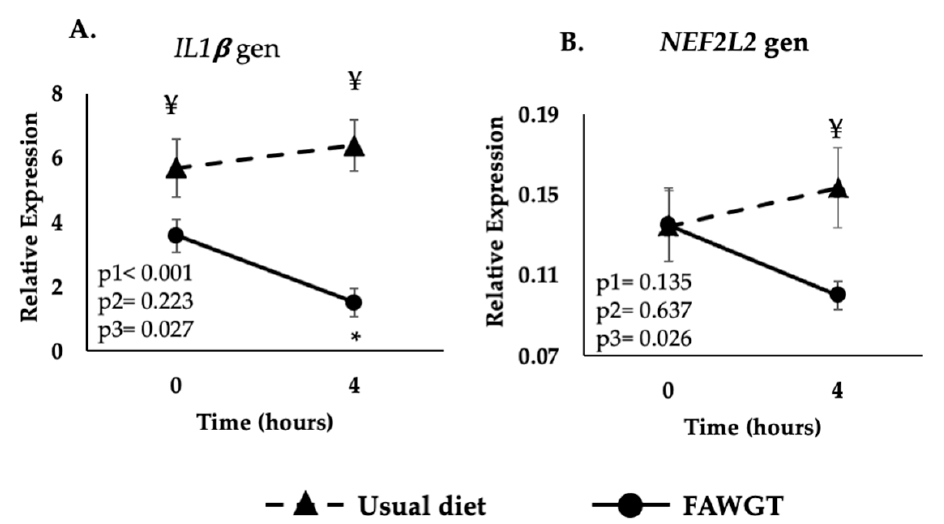
Figure 3. Postprandial expression of the inflammatory-related IL1 β ( A ) and oxidative-stress-related NFE2L2 ( B ) gene after 8 weeks of dietary intervention with a usual diet and the diet consisting of fruit, avocado, whole grains, and trout predominant in the Colombia coffee region (FAWGT). Values are shown as mean ± S.E.M of the relative expression. The analyses correspond to ANOVA for repeated measures where p1: diet influence; p2: time, the kinetics of the postprandial response and p3: diet–time interaction (diet vs. time). For multiple comparisons, we used the Sidak test. * p < 0.05 4 h vs. fasting state, ¥ p < 0.05 between diets at the same time.